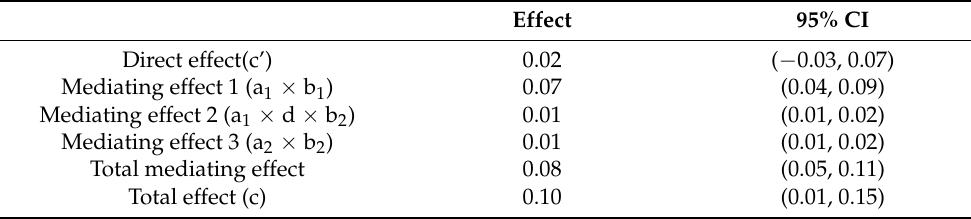
Table 3. Test of the mediating